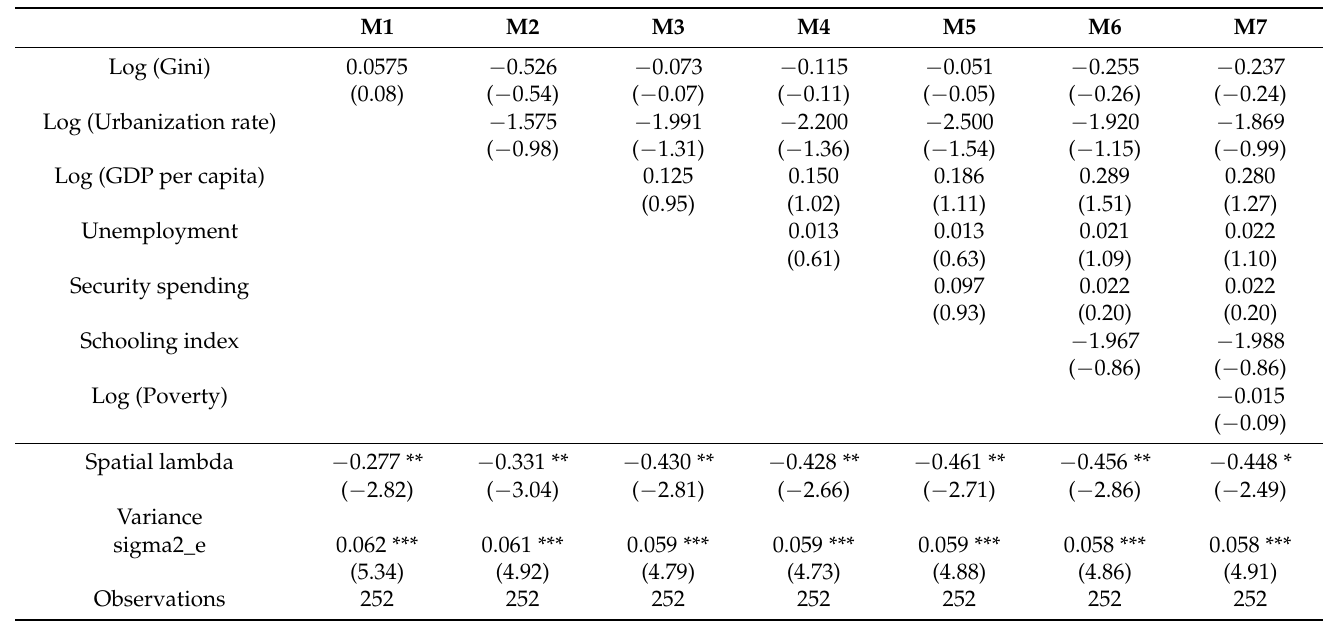
Table 10. Results of the SEM spatial model, of the relationship between inequality and the homicide rate, including the control variables.